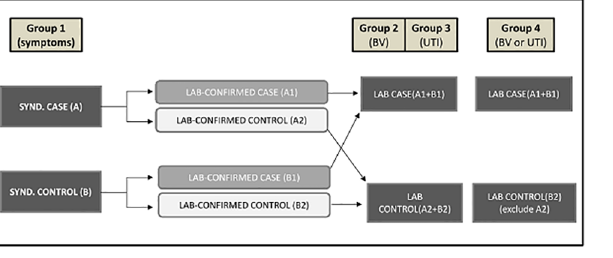
Fig 1. Definition of case-control outcomes